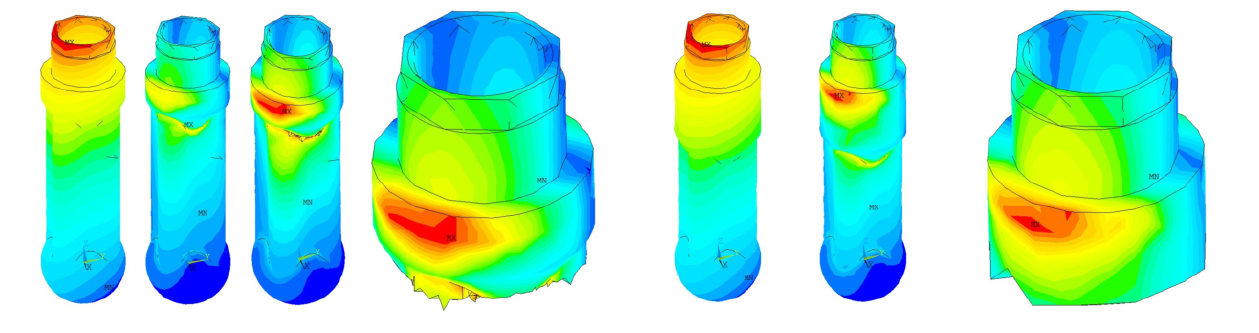
= 25 µ m (left), max = 97.1 MPa, eqv,max,1